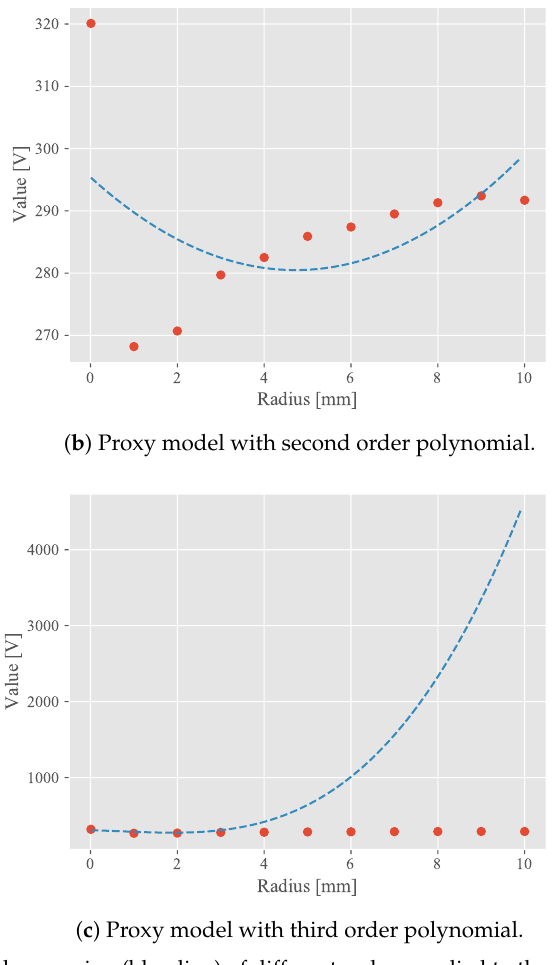
Figure 9. Polynomial regression (blue line) of different orders applied to the data presented in Table 2 (red dots). Table 3. R 2 and mean squared error (MSE) values for polynomial